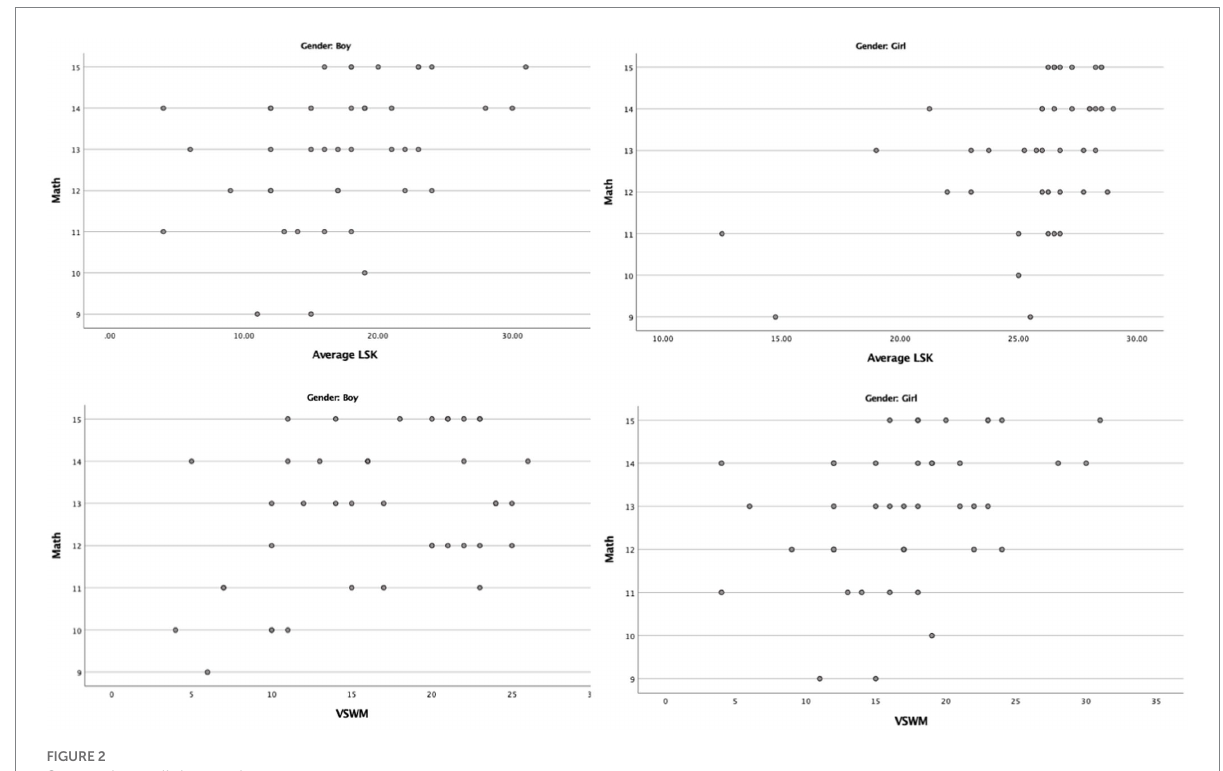
FIGURE 2 Scatterplots split by